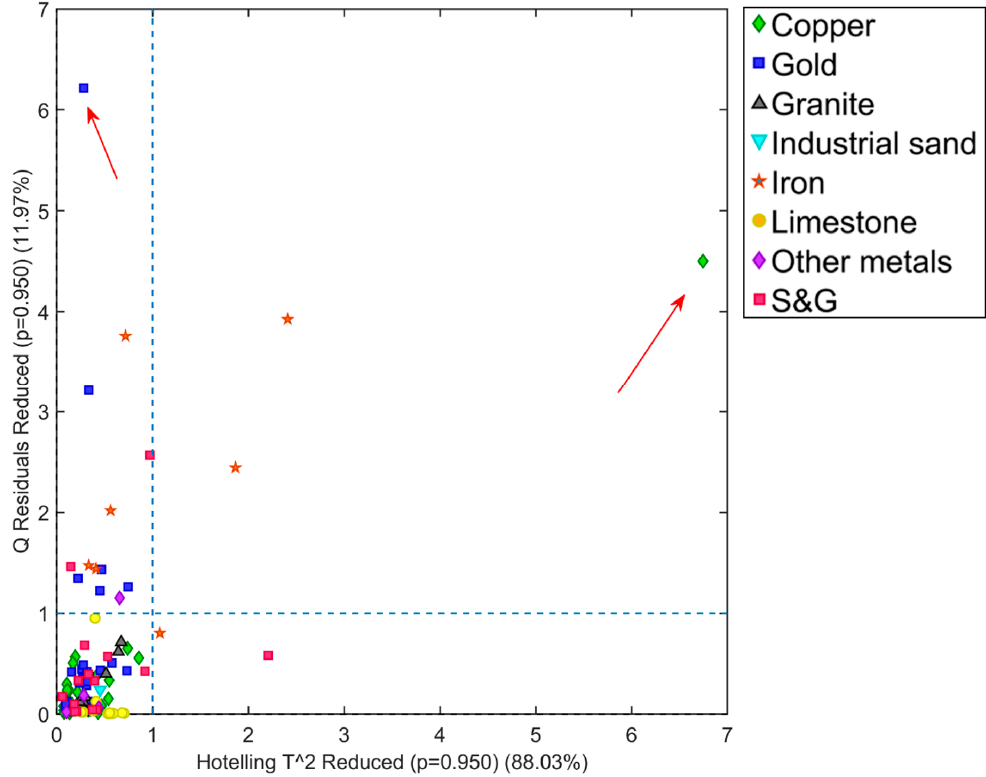
Figure A4. Hotelling T 2 v. Qresidual values of PCA model for XRD; arrows indicate copper and gold samples with unique characteristics as identified by the PCA XRD model.